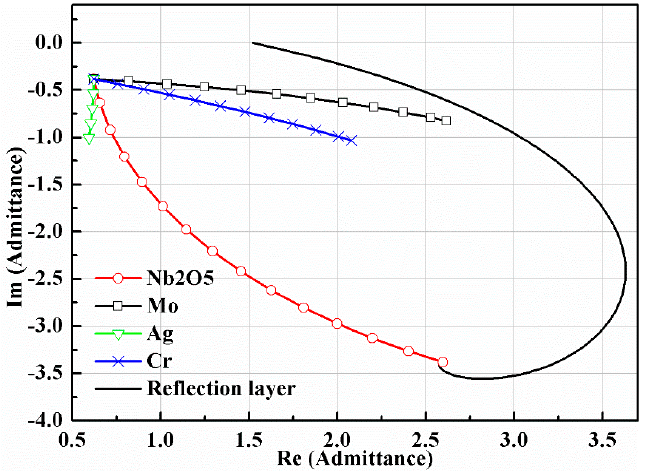
Figure 4. Admittance loci for different absorption layers.